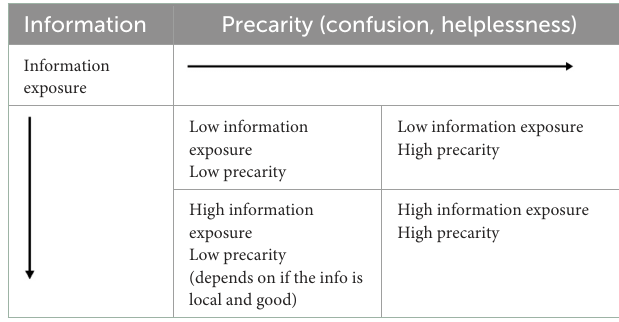
TABLE 4 Evolution of typology, step 2a–Money.